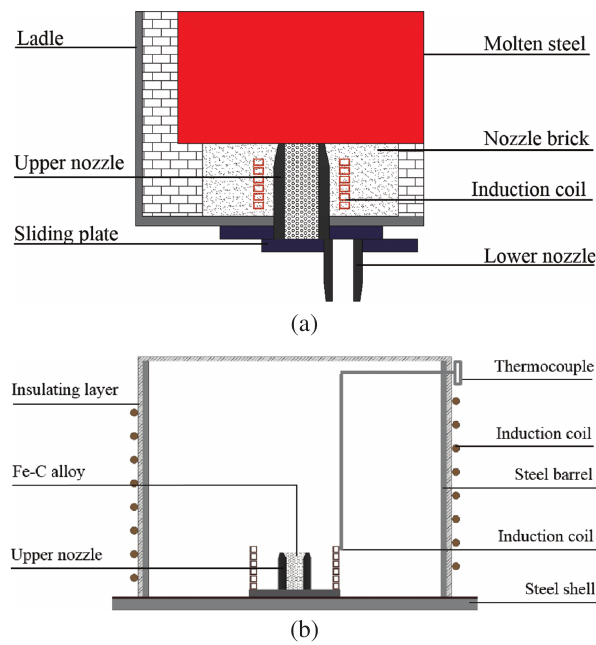
Figure 1: Schematic diagram of the electromagnetic induction heat- ing steel teeming technology: (a) basic principle, (b) high tempera- ture experimental